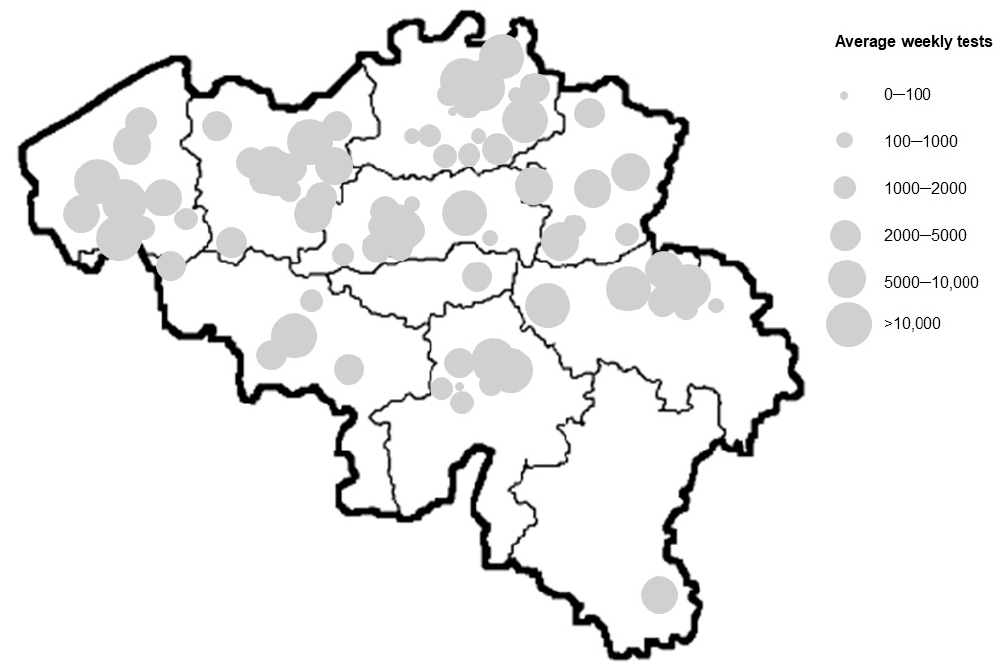
Figure 1. Geographic distribution of COVID-19 testing laboratories in Belgium that shared results of the standard curve set up with the distributed control material, with the NRC UZ/KU Leuven. The location of the laboratory is indicated by a dot of which the size is representative of the average PCR assays conducted on a weekly basis (using HealthData test results of weeks 47–49 of year 2021). For a limited number of laboratories, no weekly test data were available or test results were embedded within one of the multiple sites associated to the laboratory. Due to the close proximity of some laboratories and the high number of participating laboratories, dots are overlapping, no longer clearly visualizing the location of each participating laboratory.